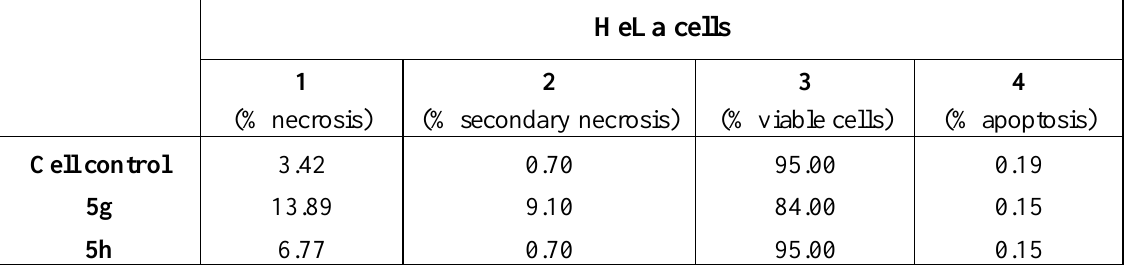
Table 7. Cytotoxic effects of the 5g and 5h on HeLa cells quantified by flow cytometry assay. HeLa cells